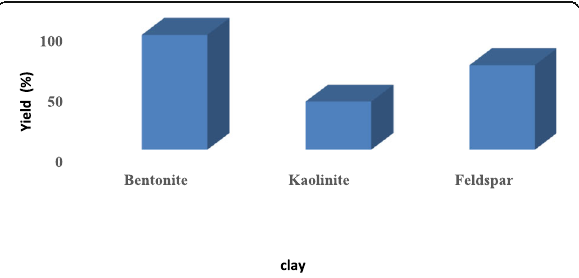
Fig. 4 Effect of clay type as substrate for the deposition of nano graphene oxide layer on the target adsorbent